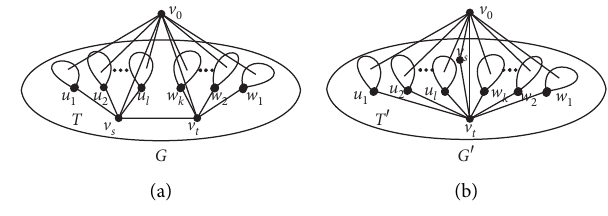
Figure 2: G and G ′ used in Lemma